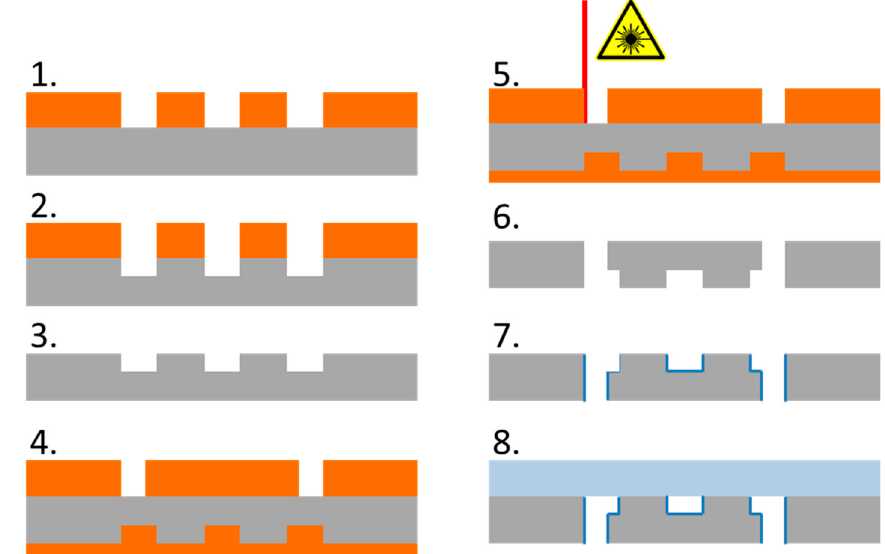
Figure 3. Schematic illustration of the microfabrication steps for a Si/glass DLD array. The steps are: 1. Photolithographic structuring of the resist for micropost arrays and connection channels; 2. Dry etching of silicon (Bosch Process); 3. Stripping of the resist; 4. Filling of the arrays with resist, structuring the resist for fluidic vias; 5. Fs-laser cutting of the vias; 6. Stripping the resist; 7. Deposition of 200 nm oxide layer; 8. Anodic bonding of glass and silicon. Micromachines 2019 , 10 , x